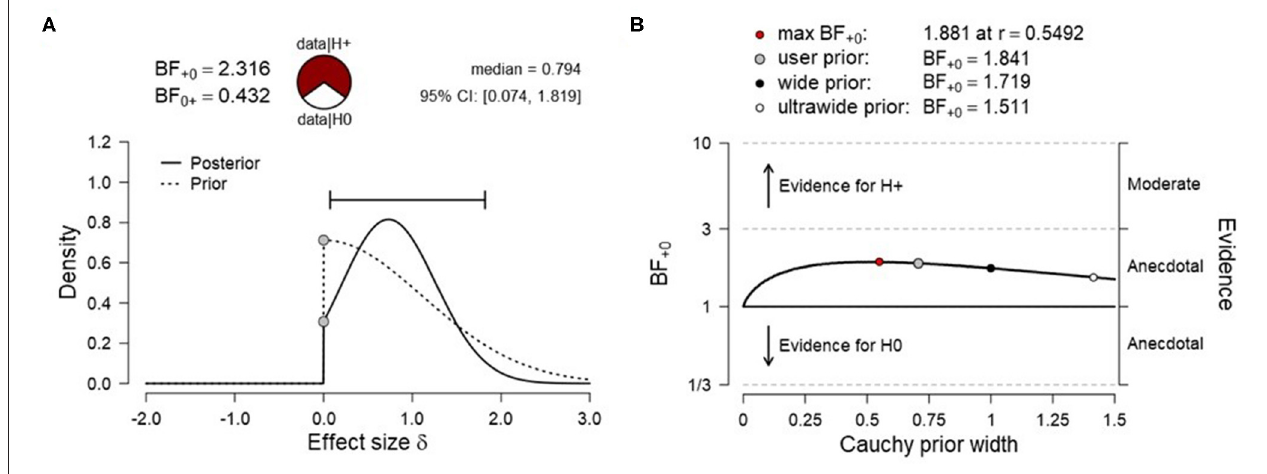
FIGURE 3 | (A) Prior and posterior distribution for Bayesian t test and associated Bayes factor and effect size estimates for H1 A [net activation of the supplementary motor area (SMA)]. (B) Corresponding prior sensitivity analysis for a set of default Cauchy prior scaling settings.